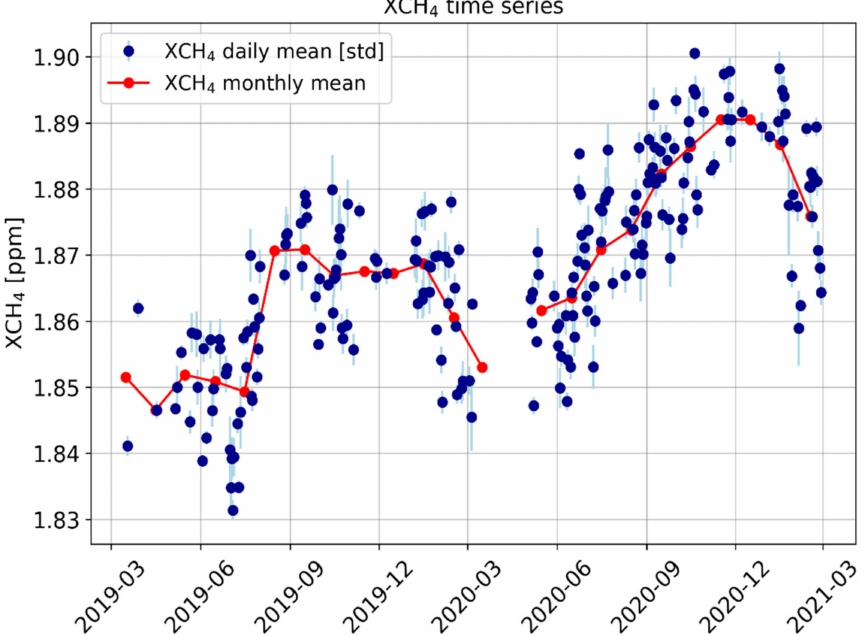
Figure 4. Dry-air mole fraction of methane over Thessaloniki from March 2019 to February 2021. Daily mean and associated standard deviation in blue dots and monthly means in red